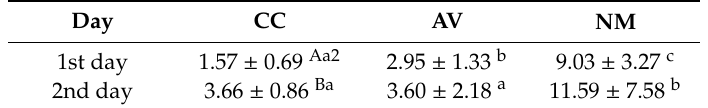
Table 4. Average NH 3 emission rates on the first and second day of manure accumulation in CC, AV, and NM (mg / h · hen) 1